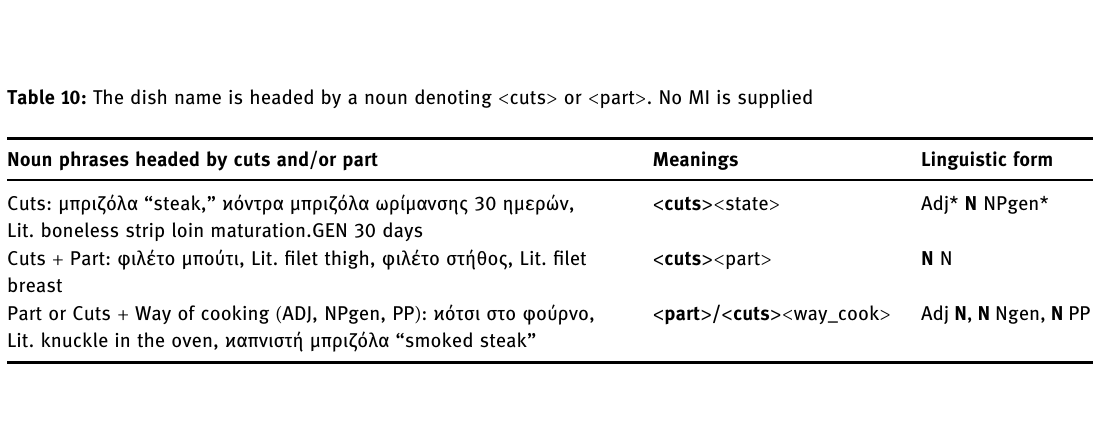
Table 11: The dish name is headed by a noun or a noun MWE with no transparent meaning Noun phrases with Dish name as head Meanings Linguistic